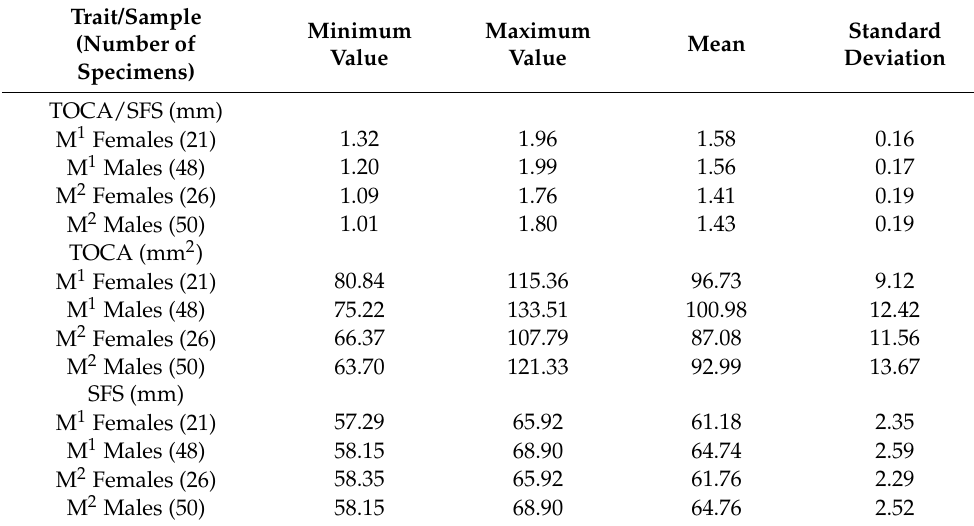
Table 3. Descriptive statistics for the relative total occlusal area (TOCA/SFS) of the permanent upper molars and the traits used to its calculation (TOCA—total occlusal area; SFS—the size of the facial skeleton) presented for all samples of two types of molars (M 1 and M 2 ) used in this study.